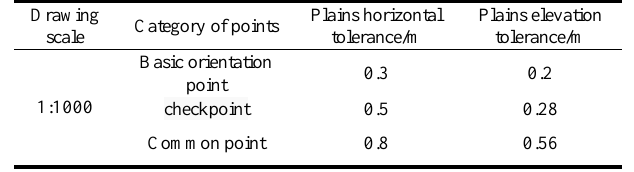
Table 3 Regional Network Evaluation Accuracy Specification